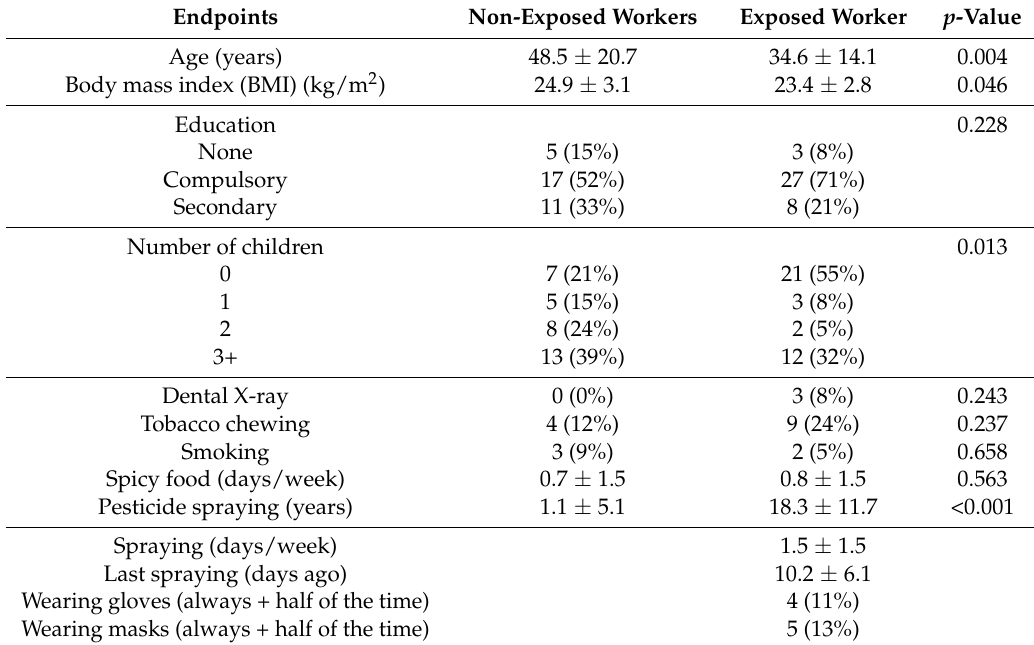
Table 1. Attributes of farmer worker (non-exposed and pesticide exposed workers), mean ± SD or number